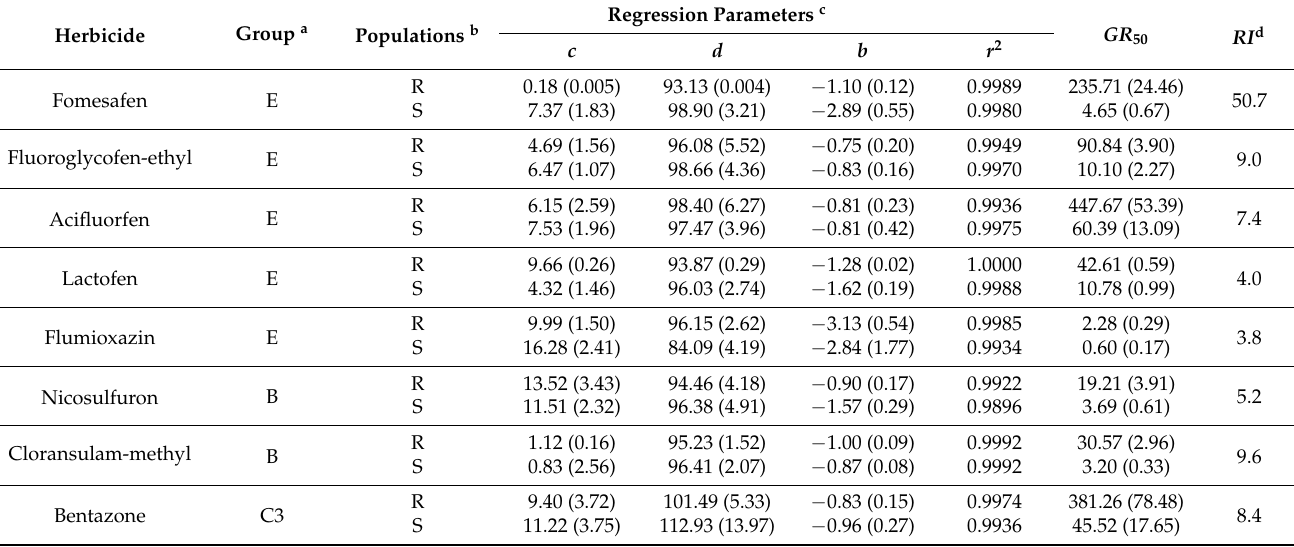
Table 3. Parameter values of the four-parameter log-logistic equation to calculate the GR 50 values of the susceptible (ST-1) and resistant (HW-01) populations of A. retroflexus with the use of the whole-plant dose–response experiments. Standard errors (SE) are in parentheses.